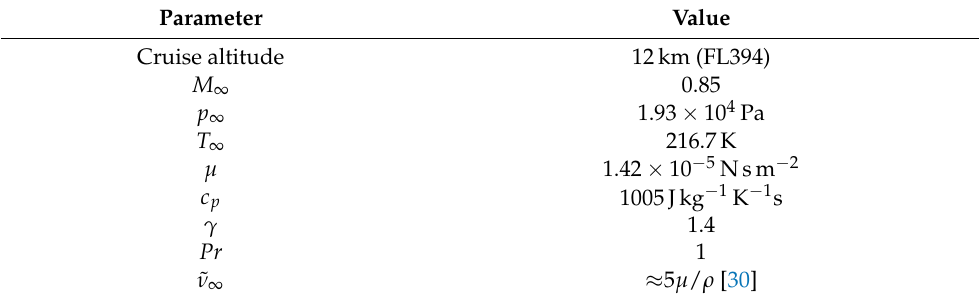
Table 1. Operating conditions.